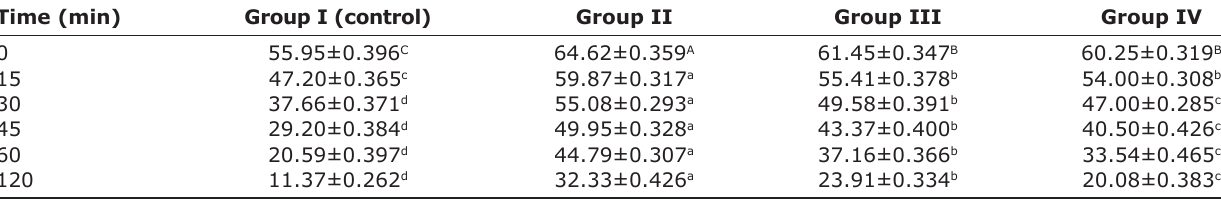
Table-4: Mean±SE of effect of incubation on post-thaw viability at various post-thaw incubation periods. Time (min)